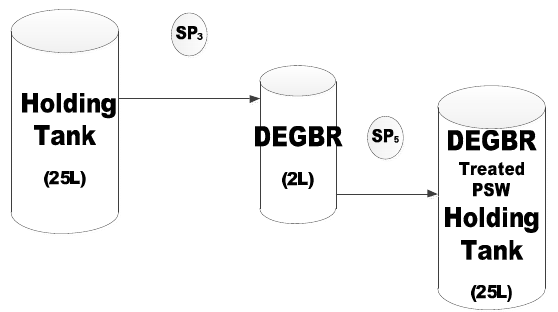
Figure 4. Reactor (EGSB and DEGBR) Set-up. (SP = sample point) The reactors were inoculated with anaerobic granules from an USAB operated at a local brewing house situated in Newlands, Cape Town. A volume (200 mL) of 50% v/w dry milk was used as a source of carbon and was fed to the granules, to assist with the acclimation of the anaerobic biomass. For optimal acclimation, mesophilic temperatures (29–36 °C) were maintained by connecting an external water bath to the reactors jacket. Reactor inoculation took a period of 72 h prior to running the reactors at 0.36 L/h and had an HRT of 5.71hr. Product released was stored in separate holding tanks for individual performance analysis conducted at an SANAS-accredited external laboratory, i.e., City of Cape Town Scientific Services. 2.2.3. Membrane Bioreactor Units Set-Up • Membrane Bioreactor design Hydrophilic polyethersulfone (PES) membranes with a 0.04-mirometre pore size and a glycerine (20%)/sodium benzoate (3%) preservative were housed in a 315 × 182 × 69 mm polyvinyl chloride (PVC) module with a polyester (PET) drainage layer. The casts were submerged in 100 L aerated tanks, as illustrated in Figure 5.